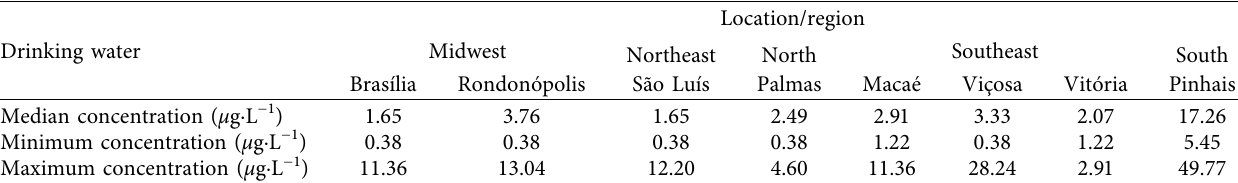
Rondon´opolis (midwest) São Lu´ıs (northeast) Palmas (north) Maca´e (Southeast) Viçosa (southeast) Vit´oria (Southeast) Pinhais (south)